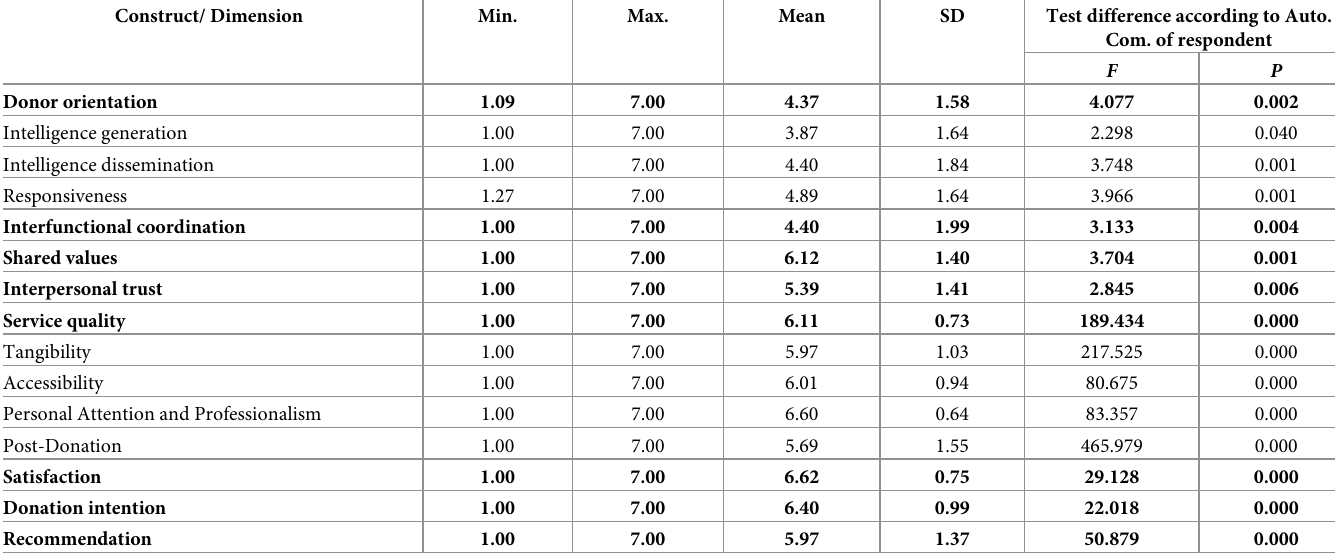
Table 4. Descriptive statistics of the model